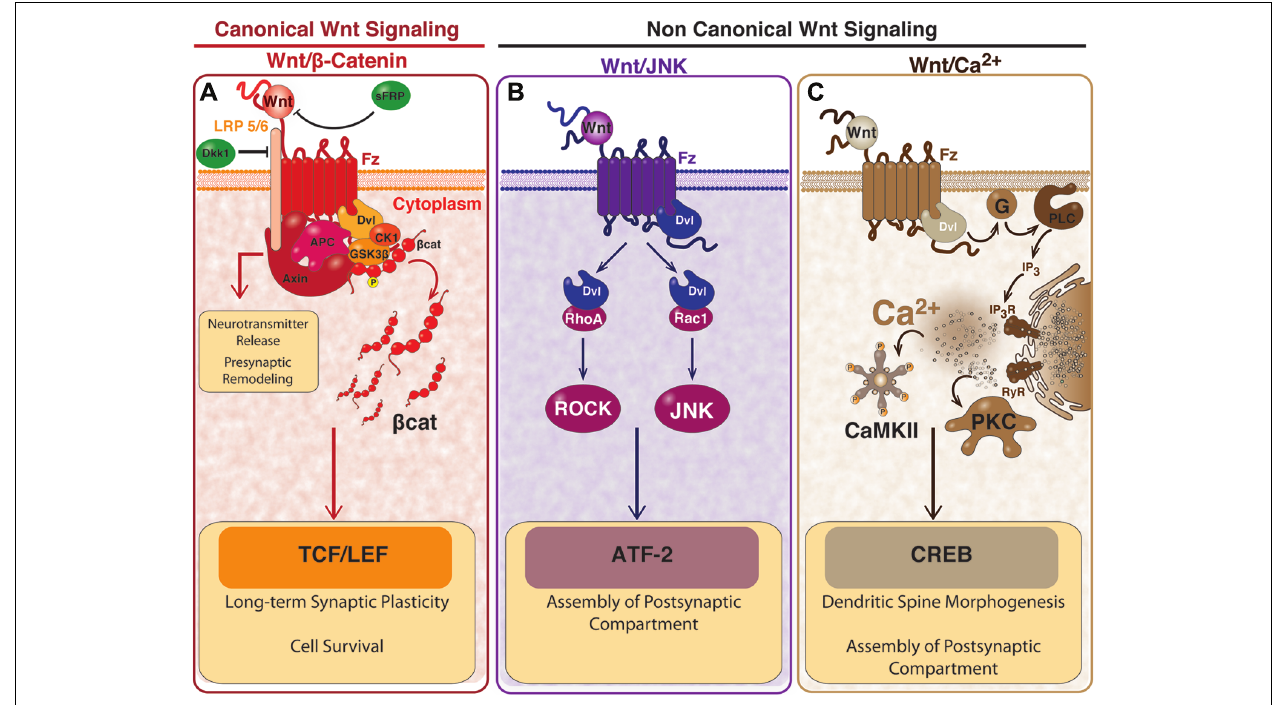
FIGURE 1 |Wnt signaling pathways and the effects in mature synapses. (A) activation of canonicalWnt/ β -catenin dependent pathway starts with the binding ofWnt ligand to Fz receptor and to the co-receptor LRP5/6, which induces the recruitment of Dvl and causes the inhibition of the “ β -catenin destruction complex” formed by Axin, APC, GSK3 β , and CK1.The inhibition of the “ β -catenin destruction complex” causes the accumulation of β -catenin, which is no longer phosphorylated and it translocates to the nucleus where it activates transcription ofWnt target genes mediated byTCF/LEF. Canonical Wnt pathway participates in synaptic plasticity and cell survival. A divergent pathway involving proteins of the “ β -catenin destruction complex” participates in the clustering of pre-synaptic proteins and the neurotransmitter release.TheWnt/ β -catenin pathway can be blocked by Dkk-1 which binds to